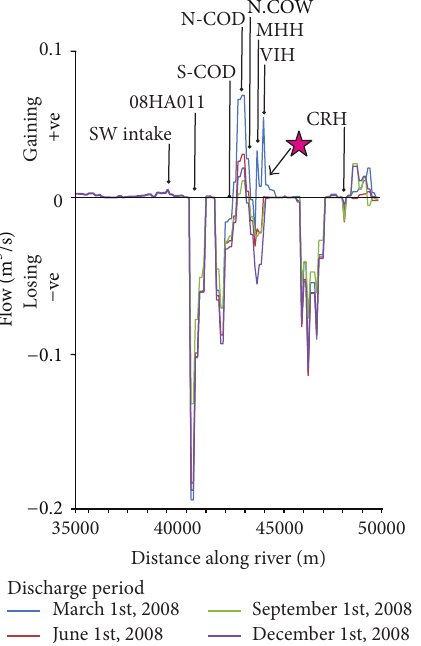
Figure 14: Seasonal variations in GW-SW interactions for the lower reaches of the Cowichan River. Note: the red star shows the location of seasonal variation of exchange conditions.